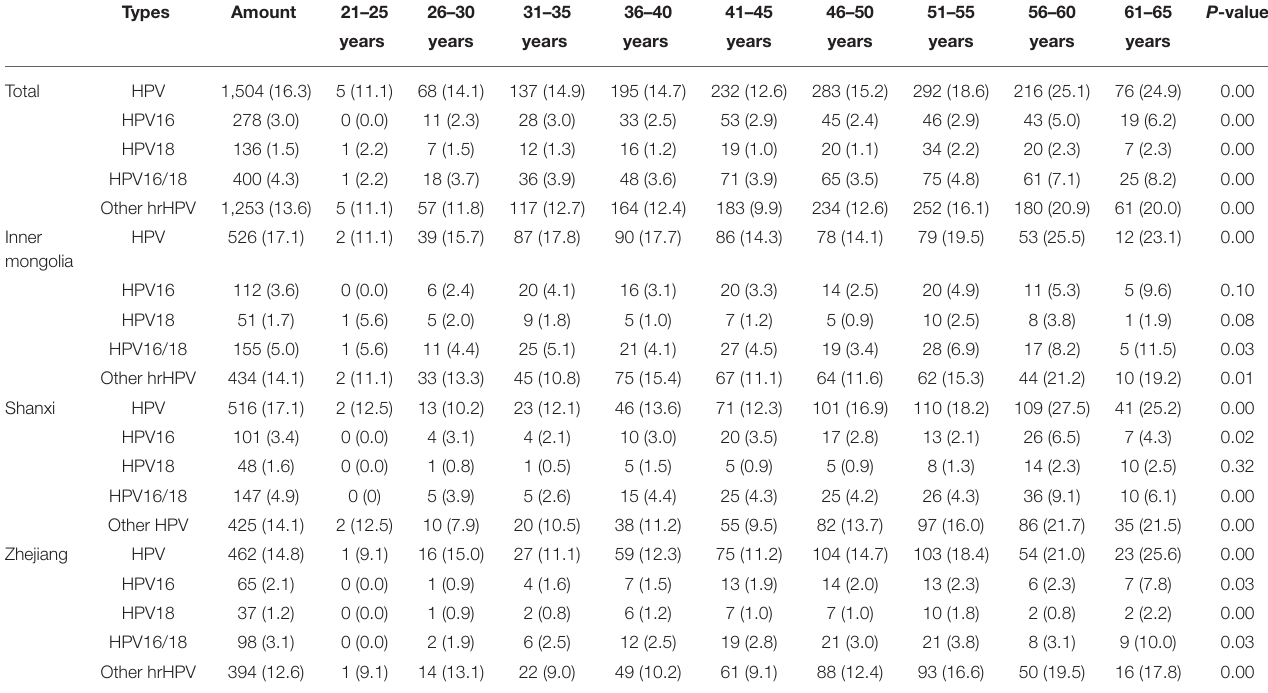
TABLE 2 | High-risk HPV infection rate and genotype distribution by age group and areas, N